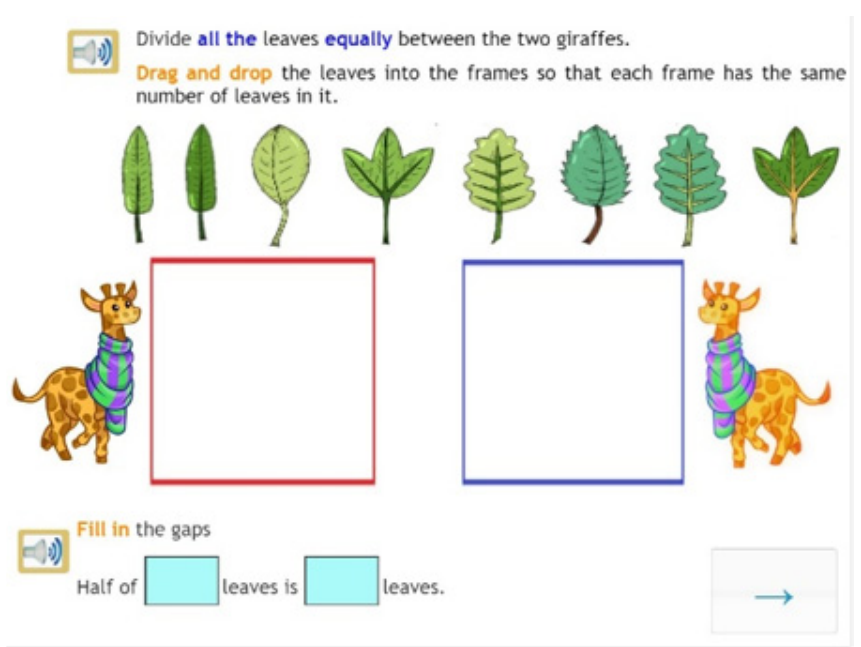
Figure 4. Example of a complex task.